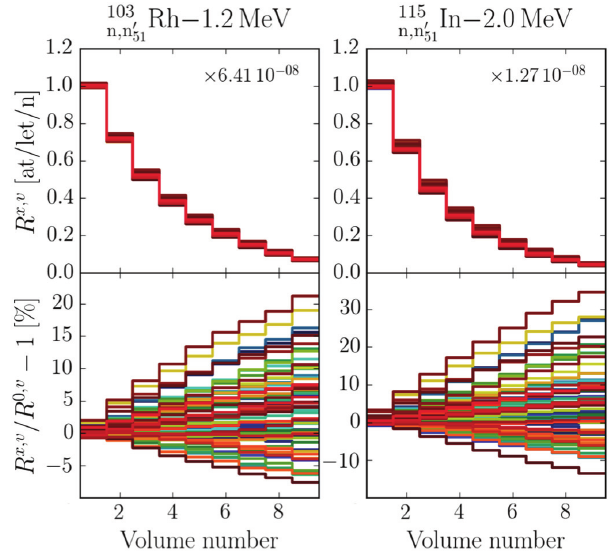
Fig. 10. Reaction rates in the foil detectors for the indium inelastic (right) and rhodium inelastic (left) reactions.